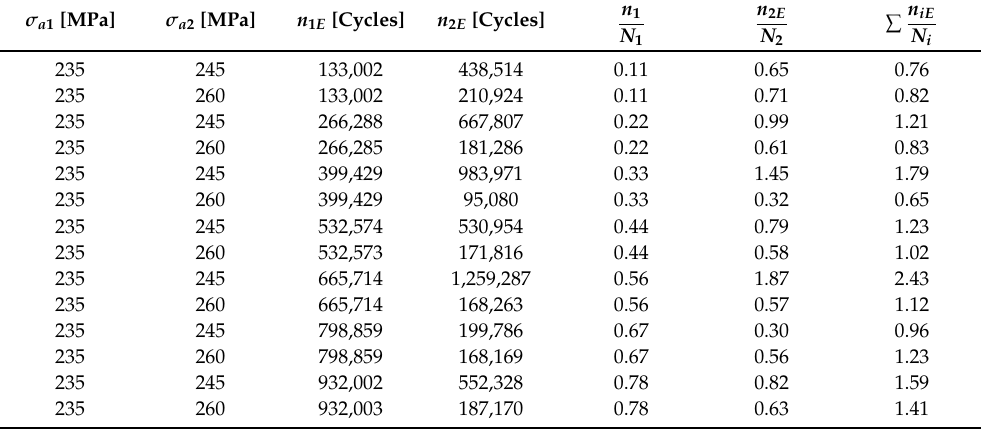
Table A6. Experimental results L–H block loading, specimens extracted from the rolling